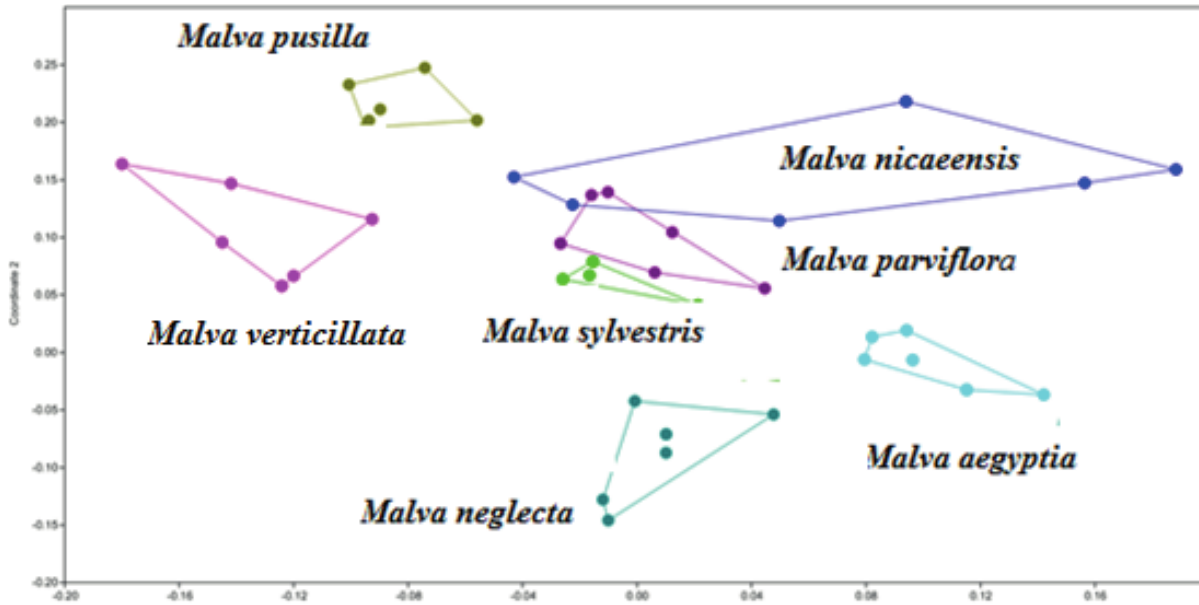
Figure 3. PCoA plot morphological characters revealing species delimitation in Malva species.